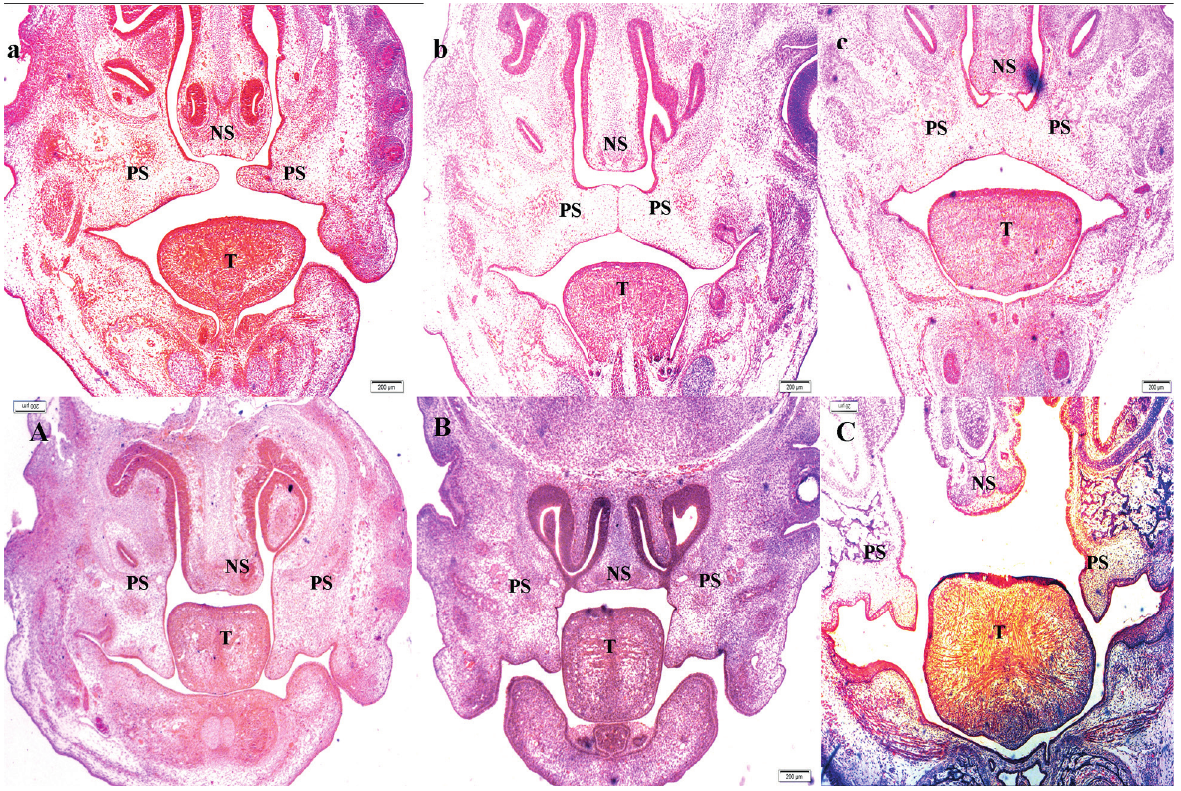
Figure 1 - Morphology and histology of palate shelf tissues at E13.5 (a, A), E14.5(b, B), and E16.5(c, C) between control vs. ATRA-treated mice. Pregnant mice were administered ATRA (70 mg/kg) by gavage at E10.5 to establish a cleft palate (CP) model in C57BL/6J mice (ATRA-treated). Control groups were given the equivalent volume of corn oil. Pregnant mice were dissected at E13.5, E14.5, E16.5 ( n =24, 3 groups, 4 ATRA-treated samples vs . 4 control samples) to obtain the embryonic palates, and then paraffi n coronal sections of palatal shelves and hematoxylin and eosin staining was performed to study the changes of morphology and histology ( n =6, 3 groups, 1 ATRA-treated samples vs . 1 control samples). (A–C) Unfused, separated palatal shelf from an embryo of an ATRA-treated mouse. a . The palatal shelf separated. b . The palatal shelf contacted the midline. c . The palatal shelf completely fused. PS, palatal shelf; T, tongue; NS, nasal septum.